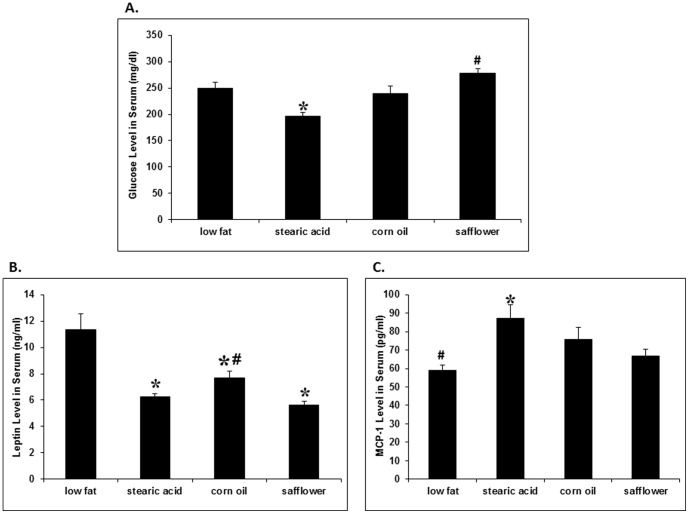
Serum analyte analysis.N = 10 per diet group. (A) Mice on the stearic acid diet had significantly reduced serum glucose compared to all other experimental groups (*, stearic acid vs. low fat, p = 0.006; corn oil, p = 0.039; safflower oil, p<0.001). Mice on the corn oil diet also had a significantly reduced level of glucose as compared to the safflower group (#, p = 0.034). (B) Mice on the high fat diets had significantly reduced levels of leptin as compared to the low fat group (*, low fat vs. stearic acid, p<0.001; corn oil, p = 0.014; safflower oil, p<0.001). Mice on the stearic acid and safflower oil diets also had a significantly lower level of leptin when compared to the corn oil group (#, p = 0.015 and 0.003, respectively). (C) Mice on the stearic acid diet had a significantly increased level of MCP-1 when compared to the low fat and safflower oil groups (*, p = 0.003 and 0.019, respectively). Mice on the low fat diet also had a significantly reduced level of MCP-1 when compared to the corn oil group (#, p = 0.032).